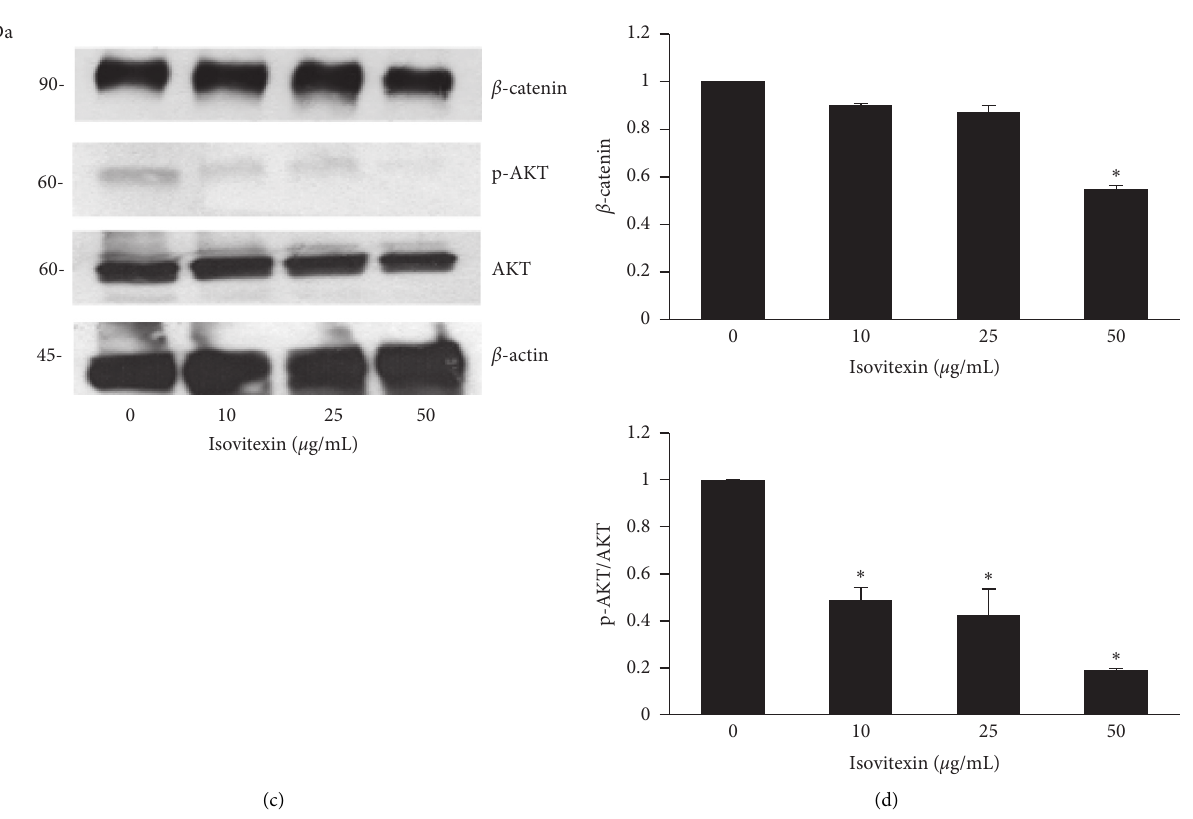
Figure 5: Cell proliferation and survival proteins expression of MCF-7 cells after treated with isovitexin. (a) MCF-7 cells were treated with isovitexin at 0–50 μ g/mL for 72h, and cell viability was determined by MTT assay. The relative cell proliferation at 24, 48, and 72h was calculated compared to time 0. (b) Colony formation was determined by microscopy (4 × ) after 14 days of isovitexin treatment. (c) The expression of β -catenin, phosphorylated AKT (p-AKT), and total AKTwere analyzed by western blot analysis after treated with isovitexin at 0–50 μ g/mL for 48h. (d) Relative protein levels were analyzed by densitometry. Data represent the mean ± SD ( n � 3). ∗ Significantly different at p < 0 . 05 versus nontreated